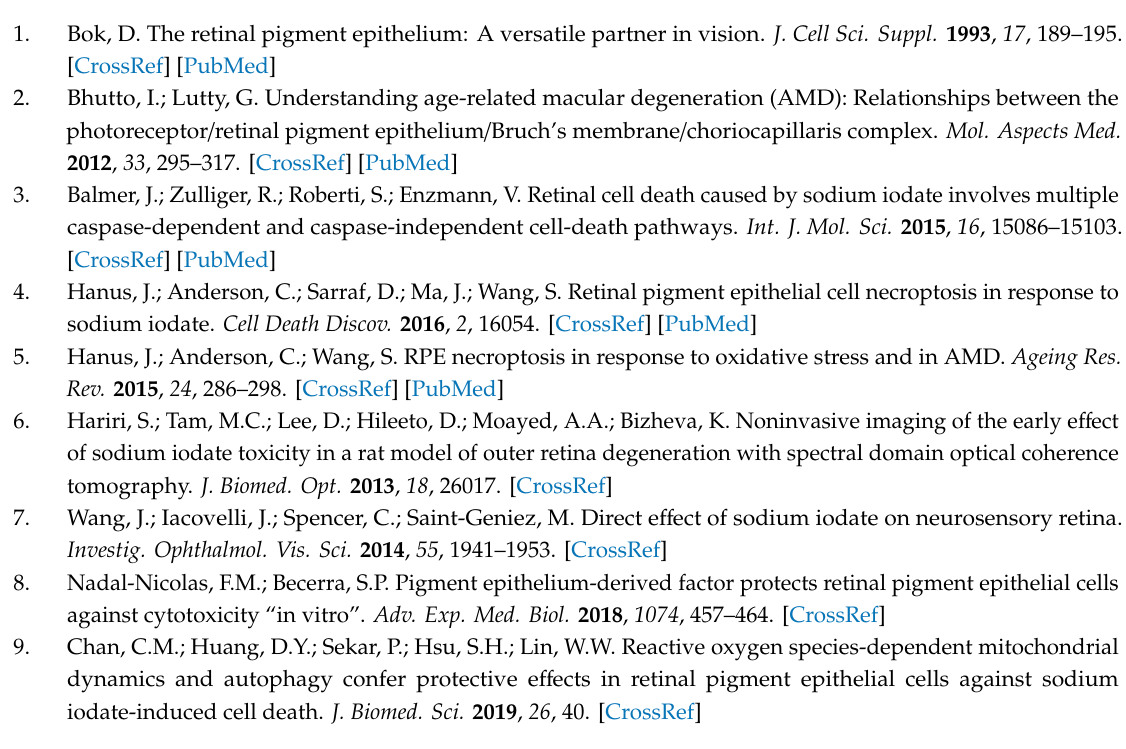
Figure S1: NAC enhances DNA damage in NaIO 3 treated RPE cells. Figure S2: A769662 and metformin do not a ff ect NaIO 3 -induced mitochondrial H 2 O 2 production nor decreased mitochondrial membrane